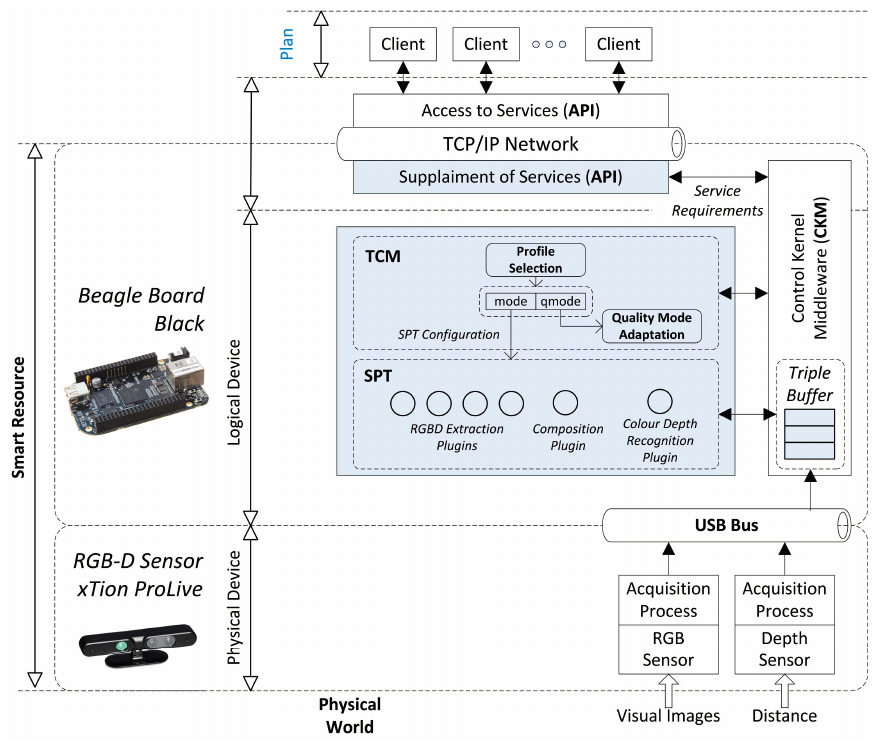
Figure 5. Smart resource implementation based on a RGBD